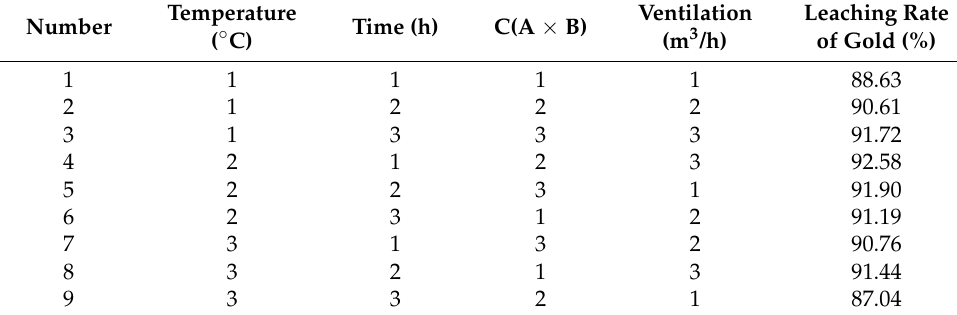
Table 5. The result of the orthogonal experiment.